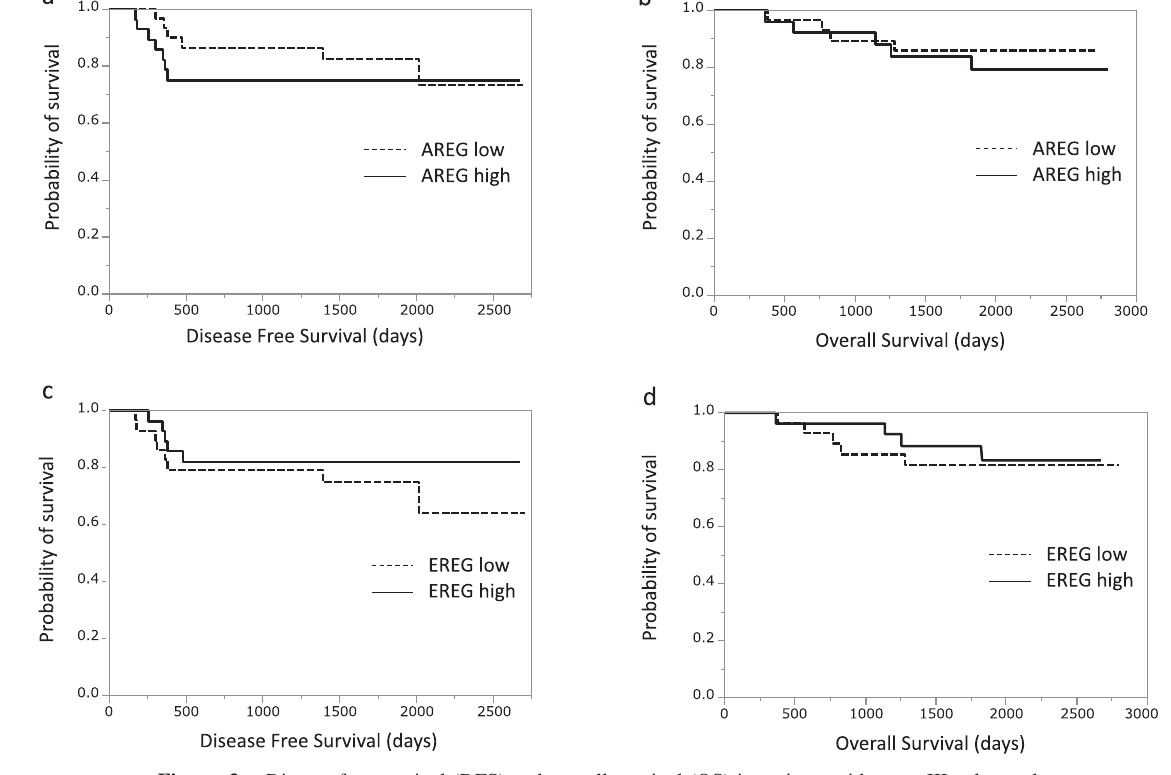
Figure 3. Disease free survival (DFS) and overall survival (OS) in patients with stage III colorectal cancer according to AREG and EREG